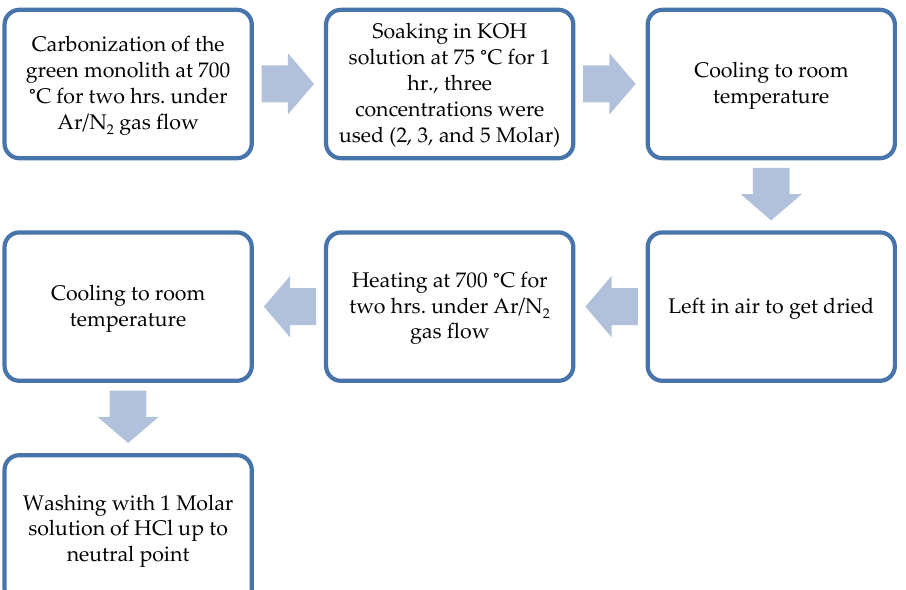
Figure 3. Steps of physical activation of the composite green monolith. 2.4. Characterization of Stabilized Fibers Three tests were performed in order to characterize the fibers after the thermal stabilization process, also to optimize the conditions of this processing step. These tests are differential scanning calorimeter (DSC, TA Instruments, New Castle, DE, USA), thermal gravimetric analysis (TGA, TA Instruments, New Castle, DE, USA), and elemental analysis (Elementar Analysen Systeme GmbH, Langenselbold, Germany).